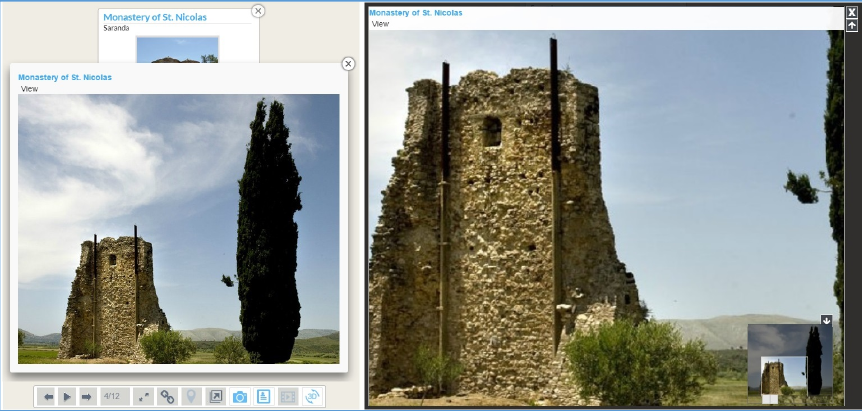
Figure 7. The interactive map—”Folder” window ( left ) with an image preview; it is possible to activate an “Image viewer” with the overview panel ( right ).